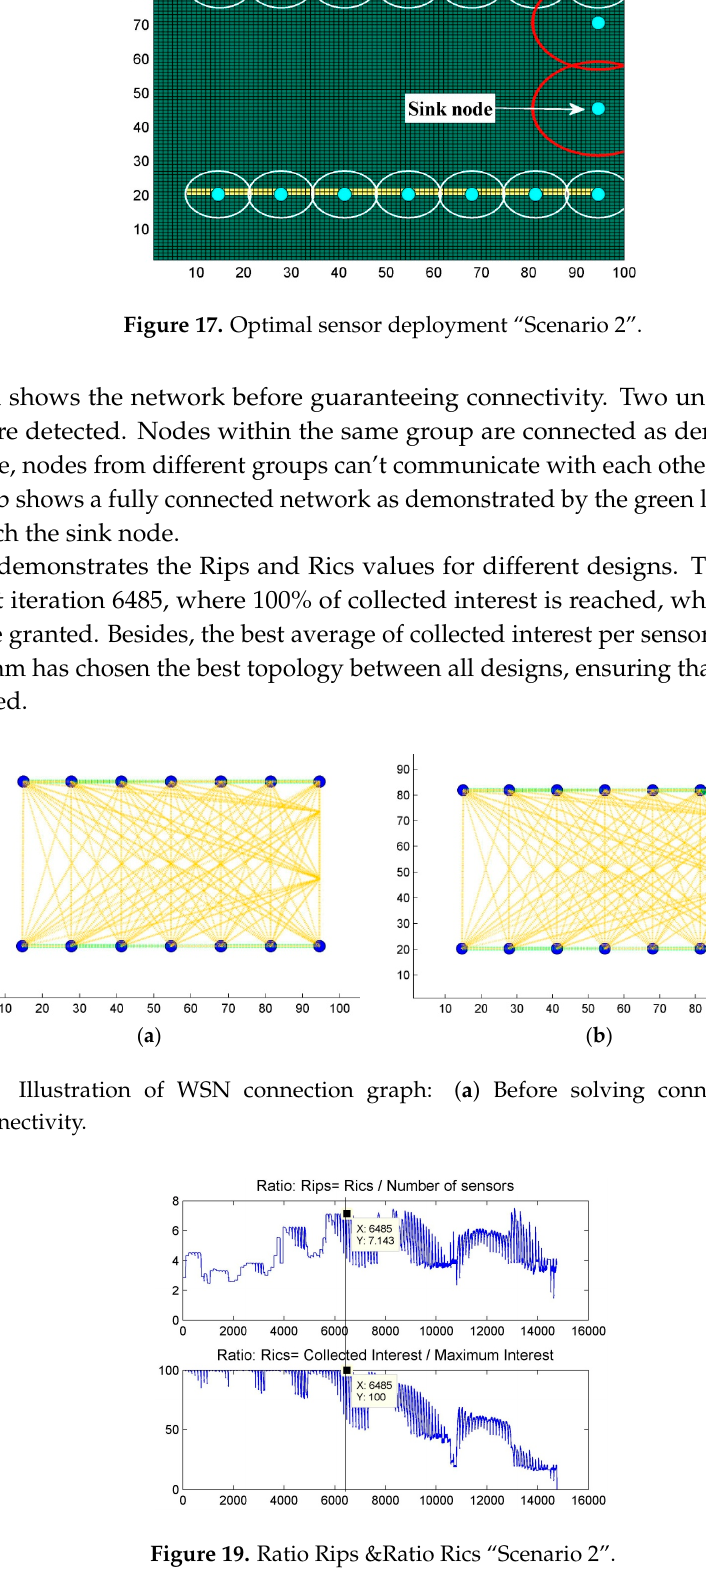
Figure 19. Ratio Rips &Ratio Rics “Scenario 2”.